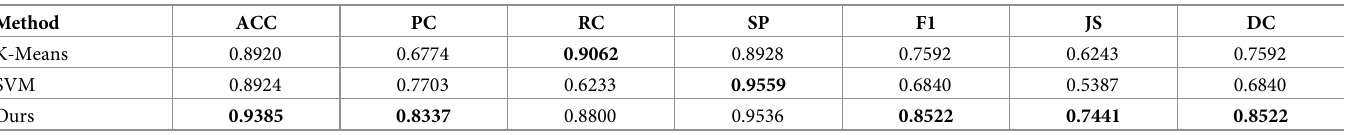
Table 3. Comparison with traditional machine learning methods.